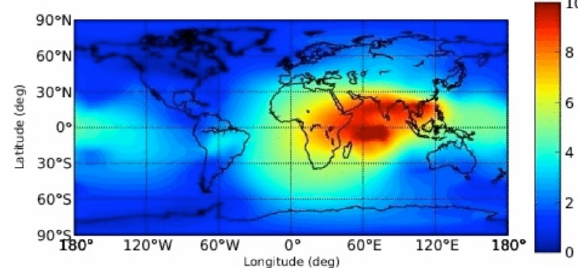
Figure 4. GIM at 06:47 UTC on March 11,